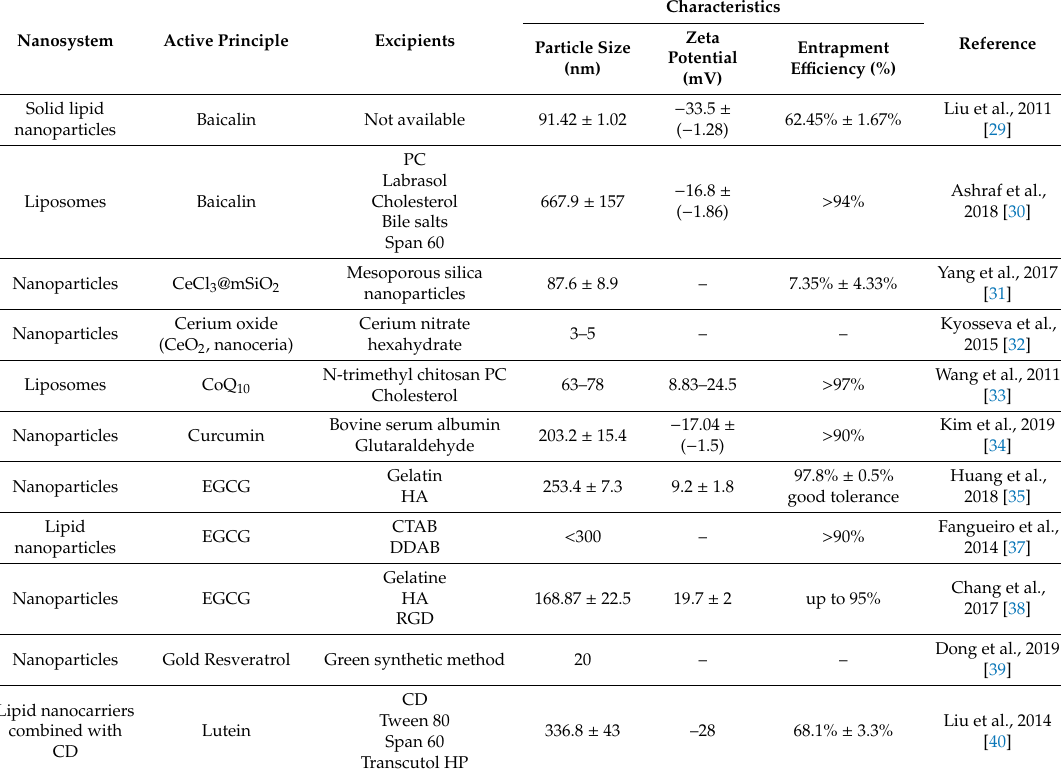
Table 1. Ophthalmic nanoformulations with